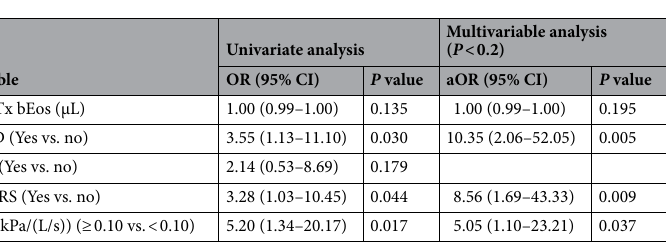
Table 2. Logistic regression model for poorly-controlled asthma (ACT < 20). Eighteen patients with poorly controlled asthma were included in the study cohort. We selected variables with P < 0.2 in univariate analysis and then performed multivariable logistic regression analysis. (See detailed logistic regression analysis in Supplementary table 3). AR, allergic rhinitis; CAD, coronary artery disease; COPD, chronic obstructive pulmonary disease; CRS, chronic rhinosinusitis; FDR, frequency-dependent resistance; the difference in resistance at 5 Hz and 20 Hz; F res , resonance frequency; OR, odds ratio; Post-tx bEos, blood eosinophil level after asthma treatment with steps 4–5